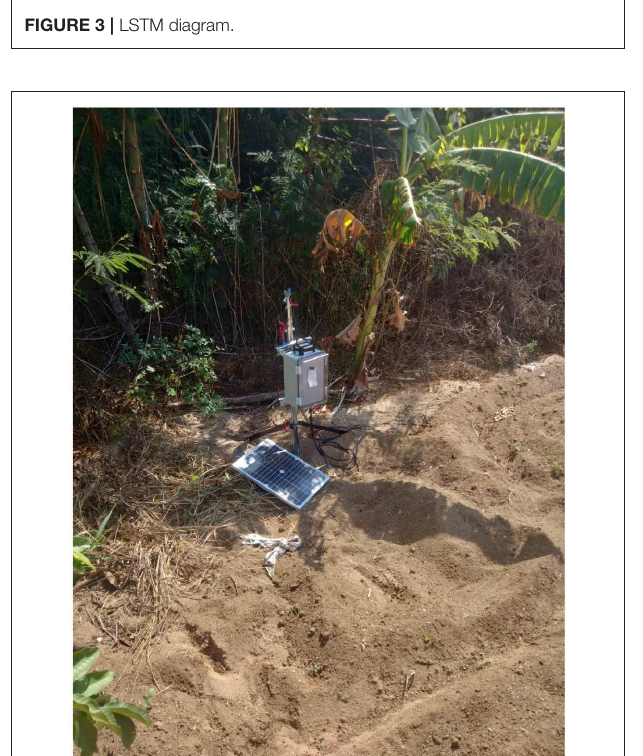
FIGURE 4 | Experimental area.